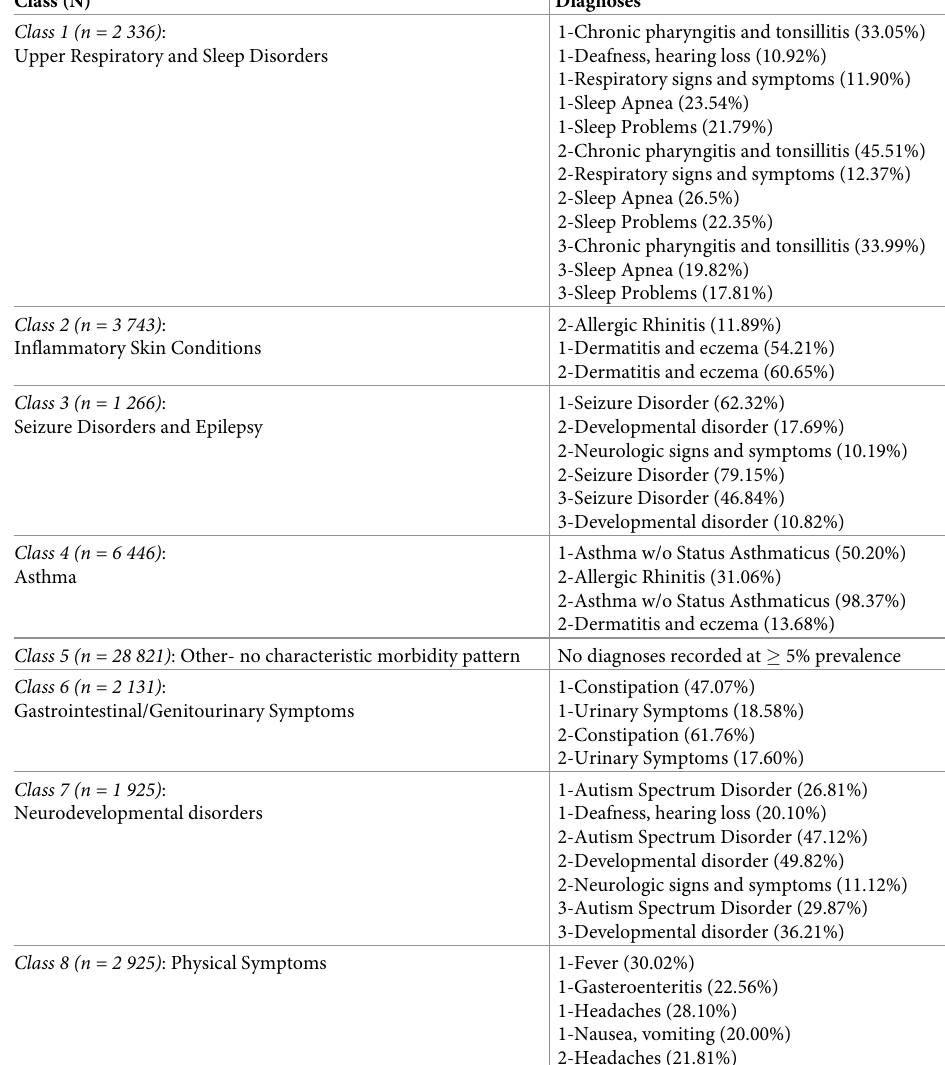
Table 3. Prevalence Rates of Common Temporal Diagnoses by Patient Subgroup (n = 49 594